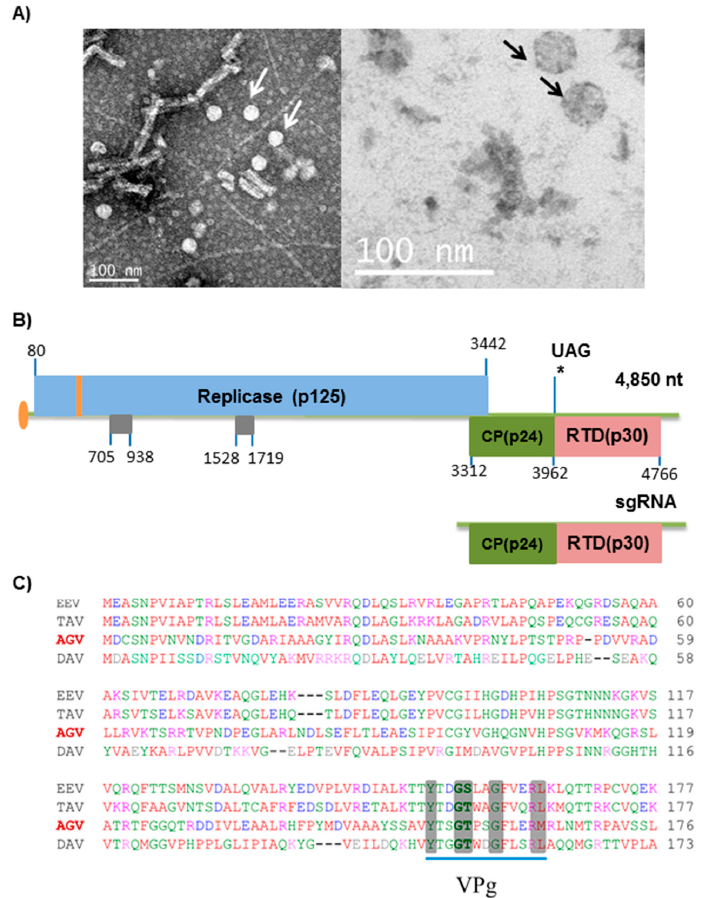
Figure 1. Aphis glycines virus 2 (ApGlV2) morphology and genomic structure. ( A ) Virions of